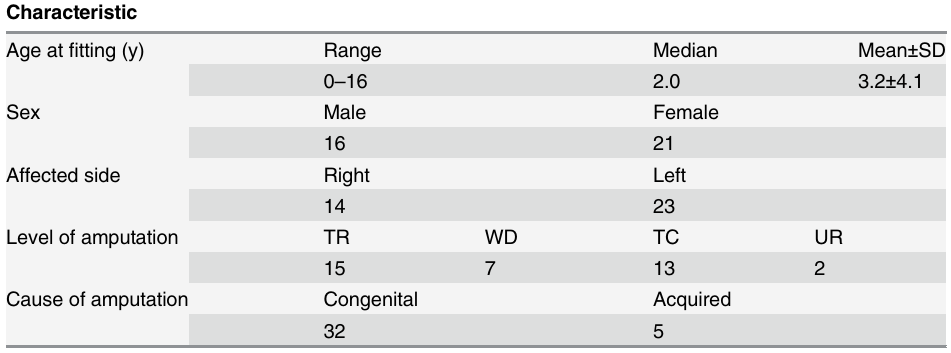
Table 1. Characteristics of subjects in this